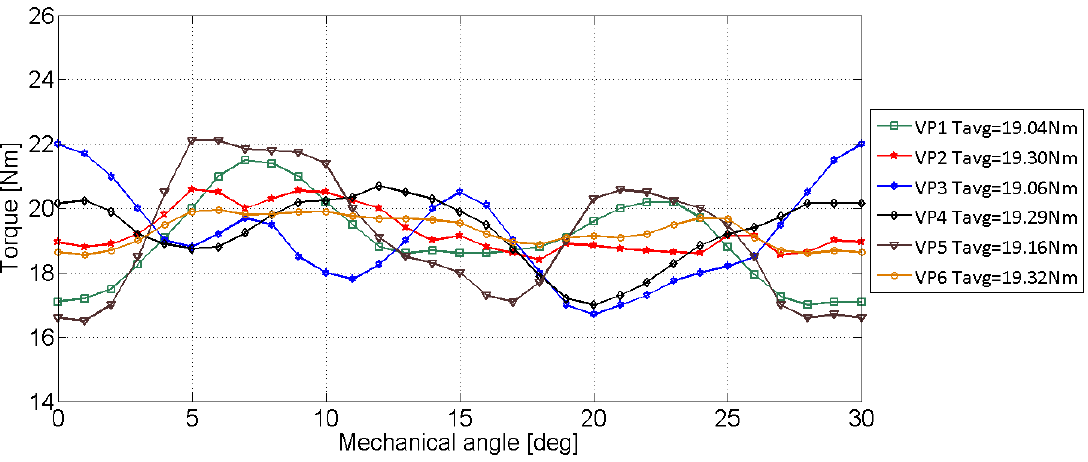
Figure 3. Torque variation .